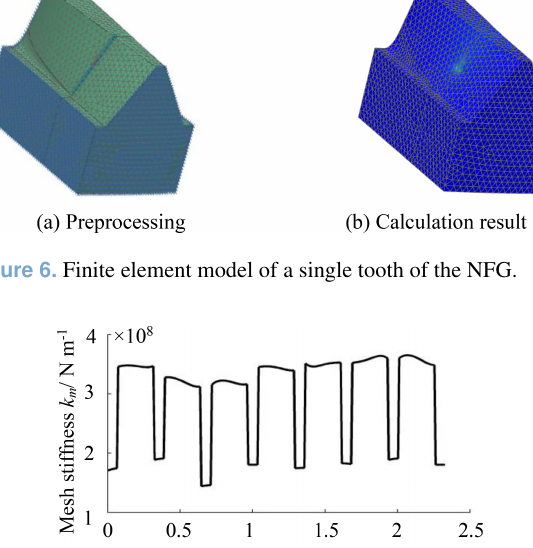
Table 1. Parameters of the NFG